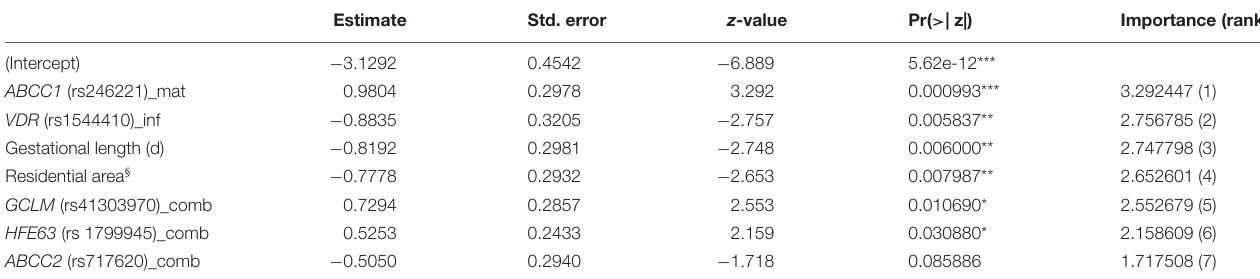
TABLE 9 | Factors associated with SGA (Log-linear model). Estimate Std. error z -value